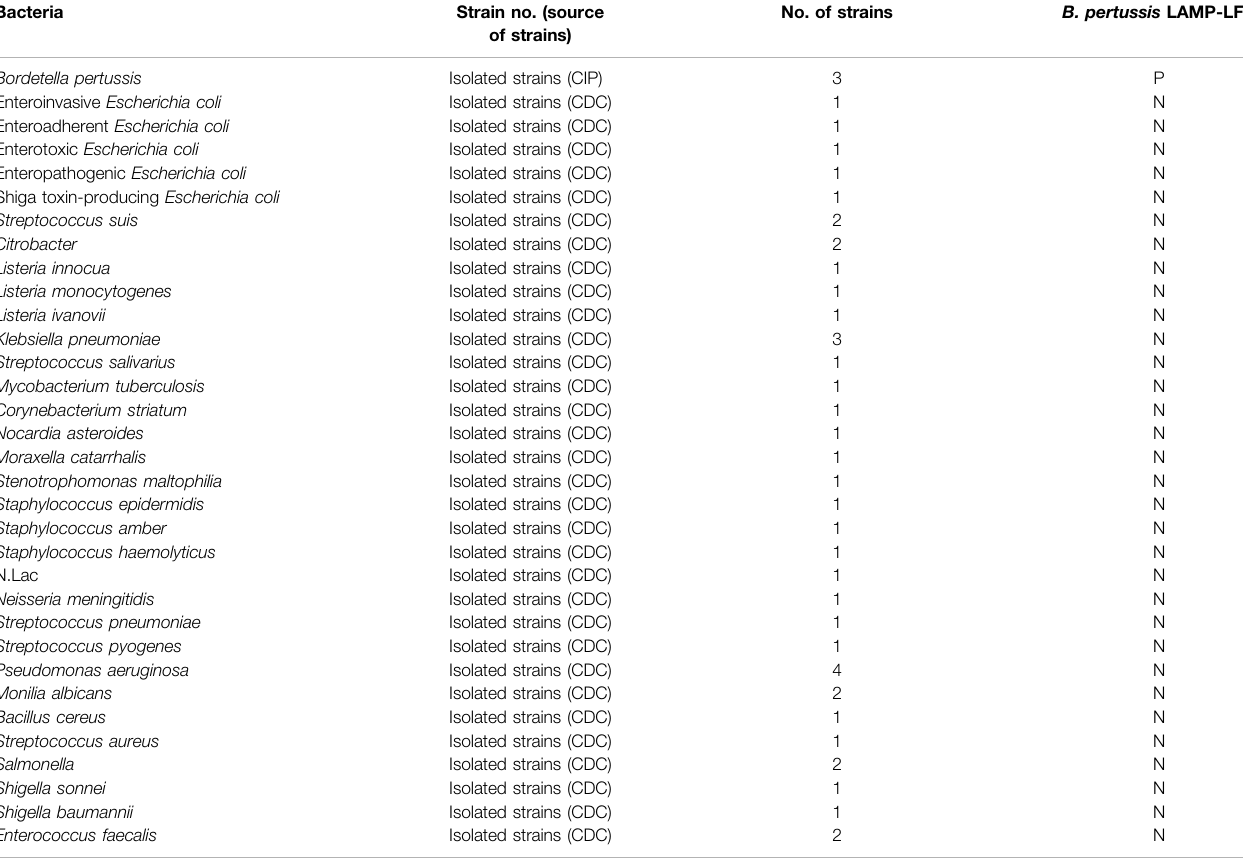
TABLE 2 | Bacterial strains used to determine the speci fi city of loop-mediated isothermal ampli fi cation (LAMP) Bacteria Strain no. (source of strains)